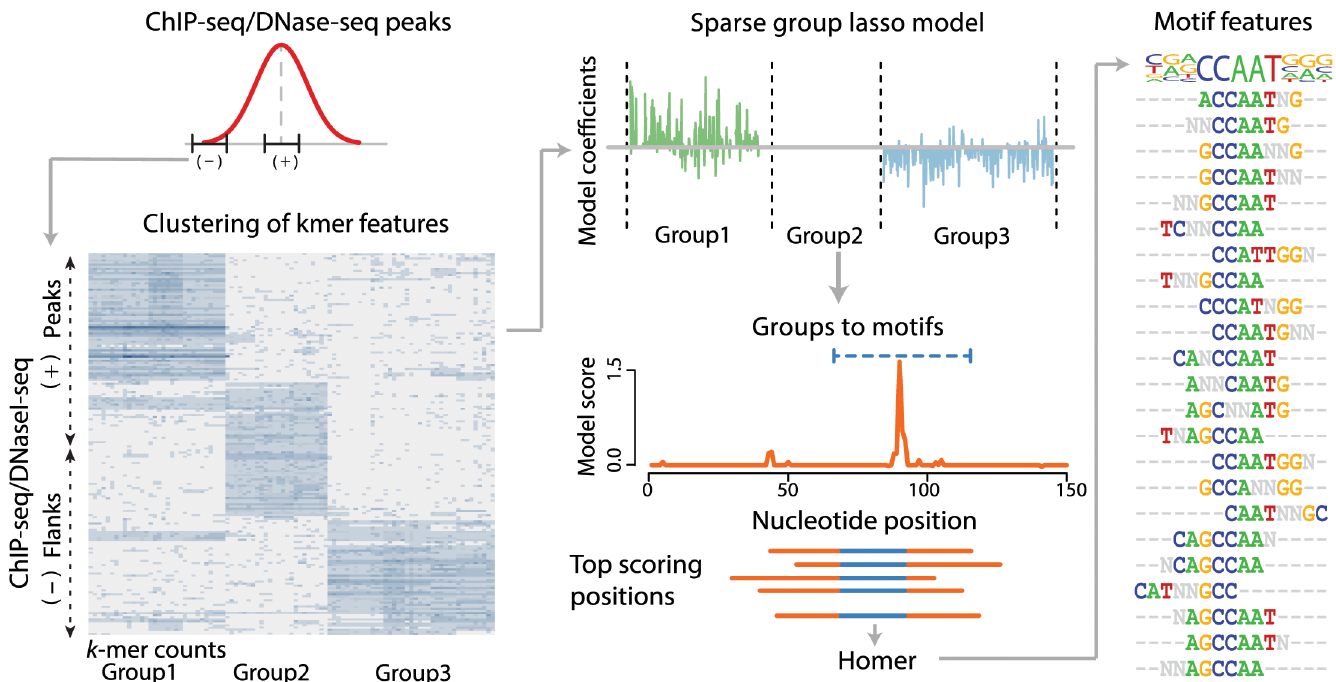
Fig 1. SeqGL identifies binding profiles in genome-wide regulatory maps. SeqGL uses sparse group lasso to identify the most important k -mer groups that discriminate between ChIP-seq/DNase-seq peaks and flanks. Hierarchical clustering of k -mer counts across peak and flank sequences reveals a block structure that defines k -mer groups. A representative heatmap of k -mer frequencies for a subset of peaks and flanks is shown. Sparse group lasso regression sets some groups uniformly to zero; groups with non-zero weights define group signals that may represent binding sequence signals for individual TFs. Significant hits for each group signal are identified, and sequence windows around these hits are extracted. HOMER is then applied to the windows to associate these group signals with motifs for visualization and